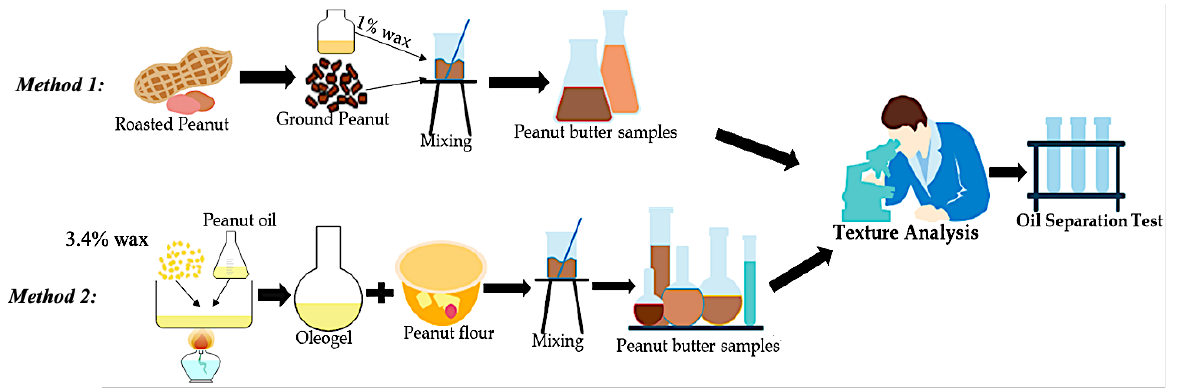
Figure 1. Flow diagram of peanut butter production.